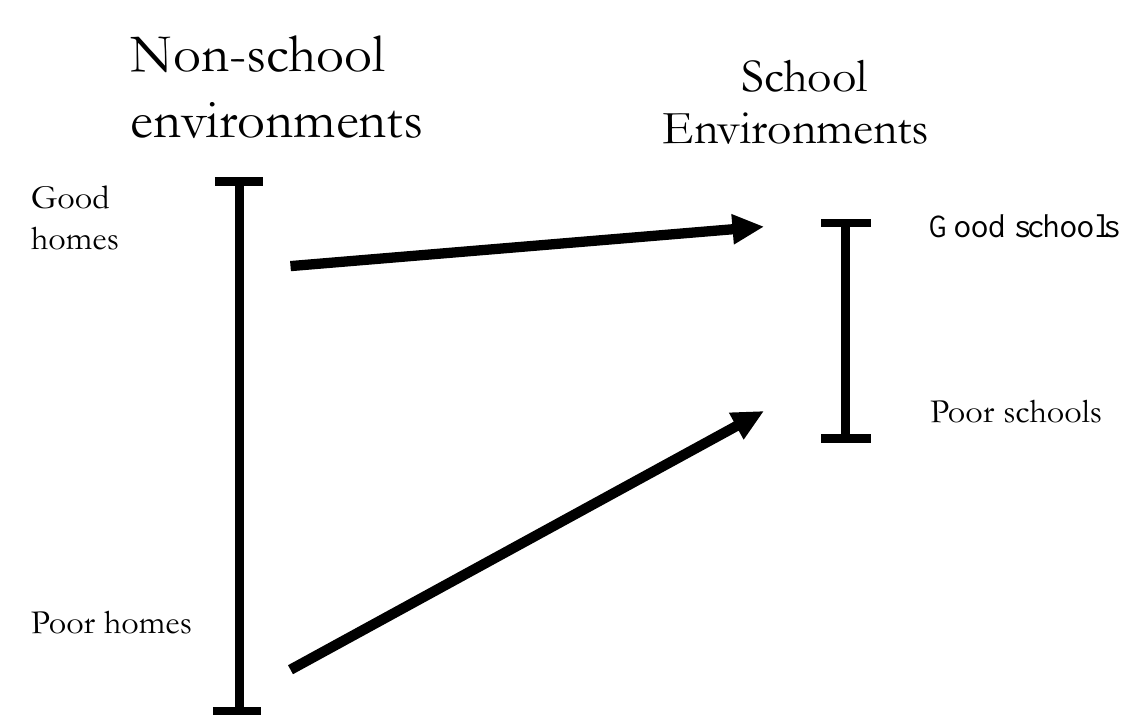
Figure 1: A Contextual View: Variation in Non-School and School Environments